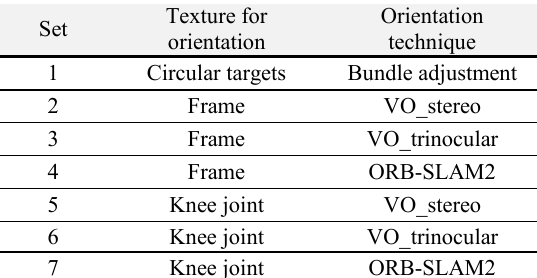
Table 1. Datasets evaluated in this work. Dataset 1 poses the reference